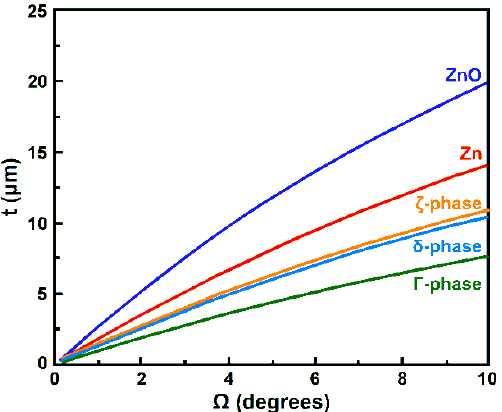
Figure 2. The dependence of the penetration depth of X-rays in Zn, ZnO and in Zn–Fe phases to the incidence angle for the grazing incidence X-ray geometry (GI-XRD). The angle corresponds to the diffraction peaks with the highest intensity.